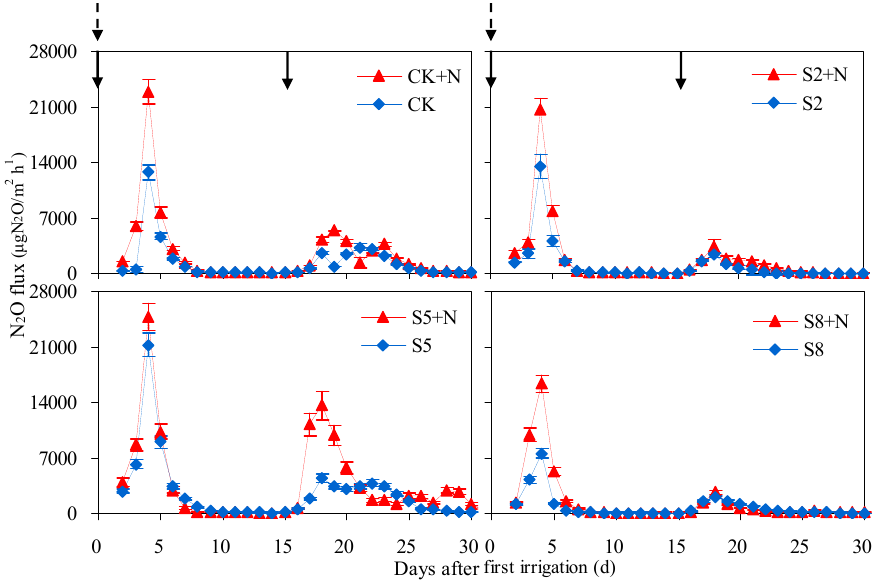
Figure 5. N 2 O emissions from soil irrigated at different salinity levels after two irrigation events from 20 July to 18 August. Solid arrow and dotted arrow represent irrigation and fertilization event, respectively. S2, S5, and S8 represent soils irrigated with water at 2, 5 and 8 g/L salinity level; S2 + N, S5 + N and S8 + N represent soils irrigated with water at 2, 5, and 8 g/L salinity level and nitrogen fertilization (120 kg N/ha) application. CK + N and CK represent soils irrigated with fresh water at N120 and N0 level, respectively. Table 2. Average N 2 O fluxes from different treatments during pulse and non-pulse periods. Treatments